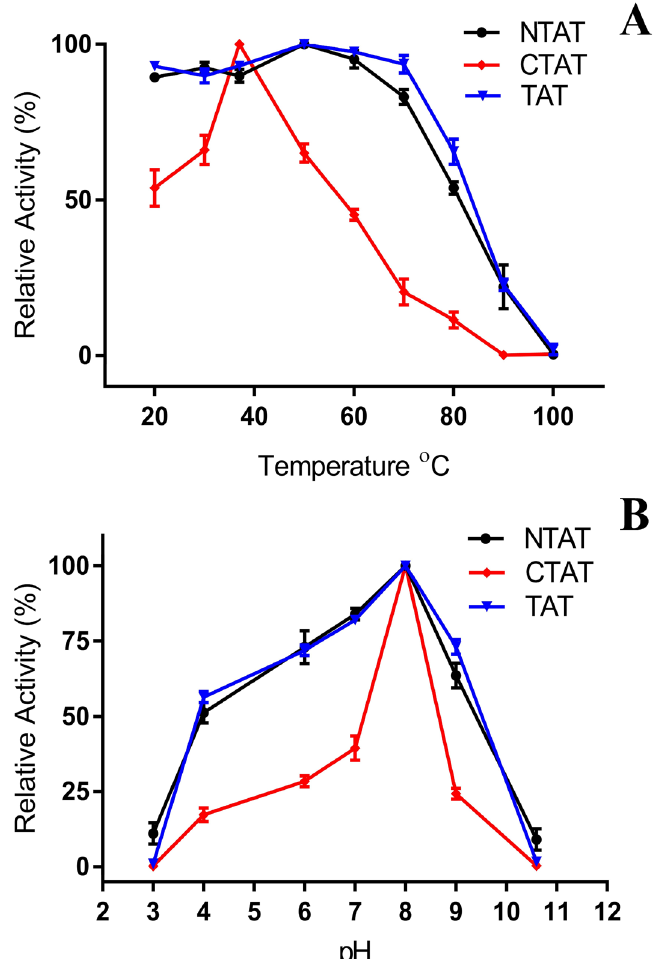
similar to that of TAT while CTAT was sensitive to temperature variation largely as seen from the plots. ( B ) The pH stability of NTAT and CTAT was checked at various pH and their activities were plotted in terms of relative activity. NTAT, as seen in temperature profile, remained stable relative to TAT 9 but CTAT displayed reduced activity at extreme pH